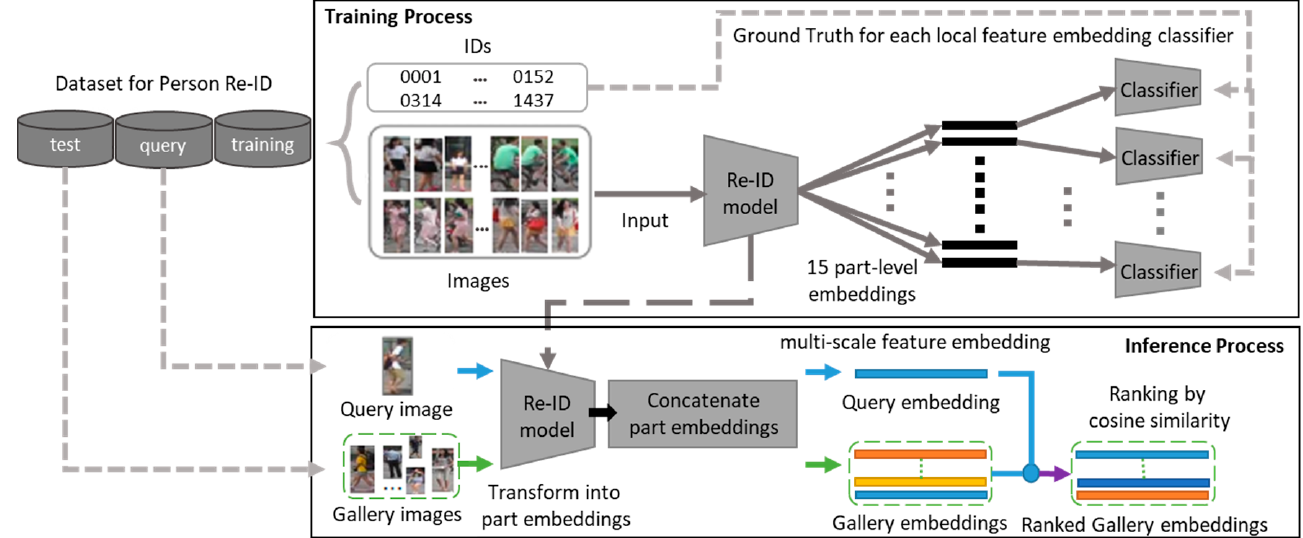
Figure 1. Process diagram of the proposed person re-identification model.